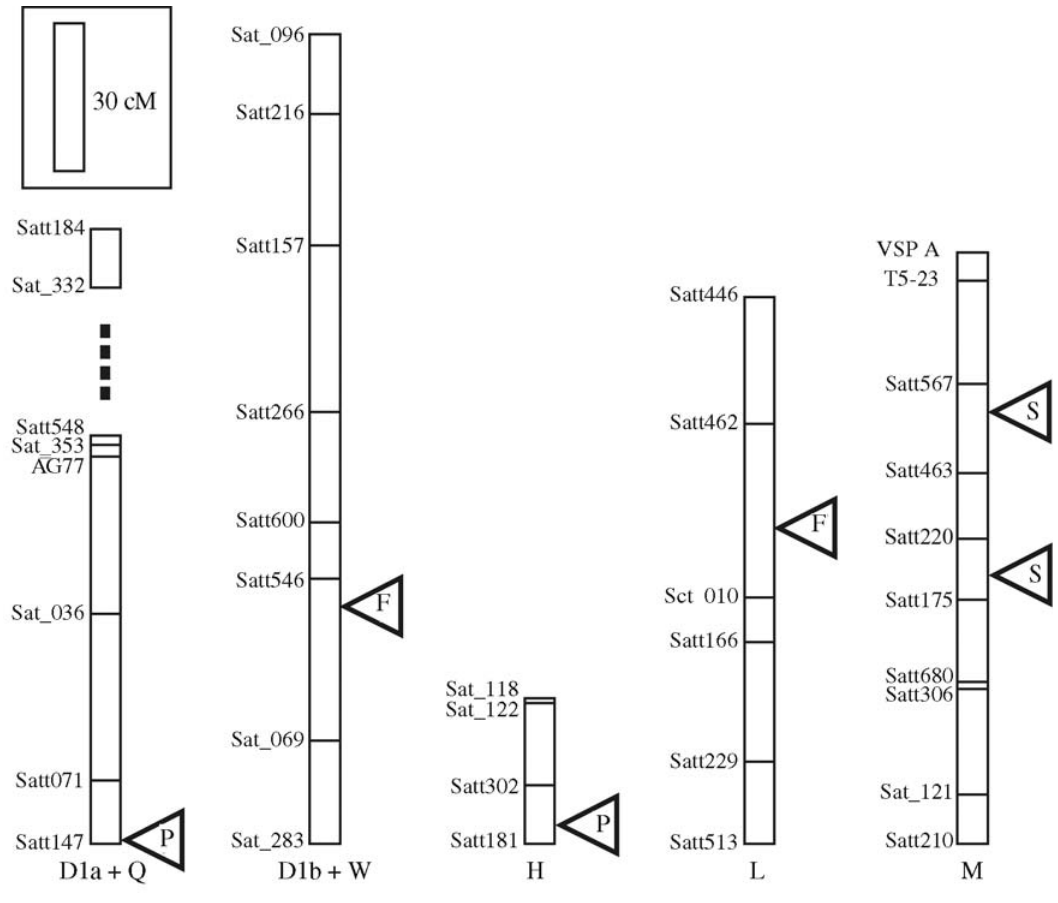
Figure 2 - Location of the quantitative trait loci (QTLs) on linkage groups (LGs) (vertical bars). Labels to the left of the bars indicate marker names. The dottedlinesinLGD1a+Qindicatebreakingoffoflinkageinourmap.TrianglespointtothepeakofthelogarithmofoddscurveforeachQTL.‘P’and‘F’ indicate pubescence density and days to flowering. ‘S’ indicates the two QTLs for antibiosis resistance to common cutworm (Komatsu et al. , 2005). The name of each LG is based on Cregan et al.